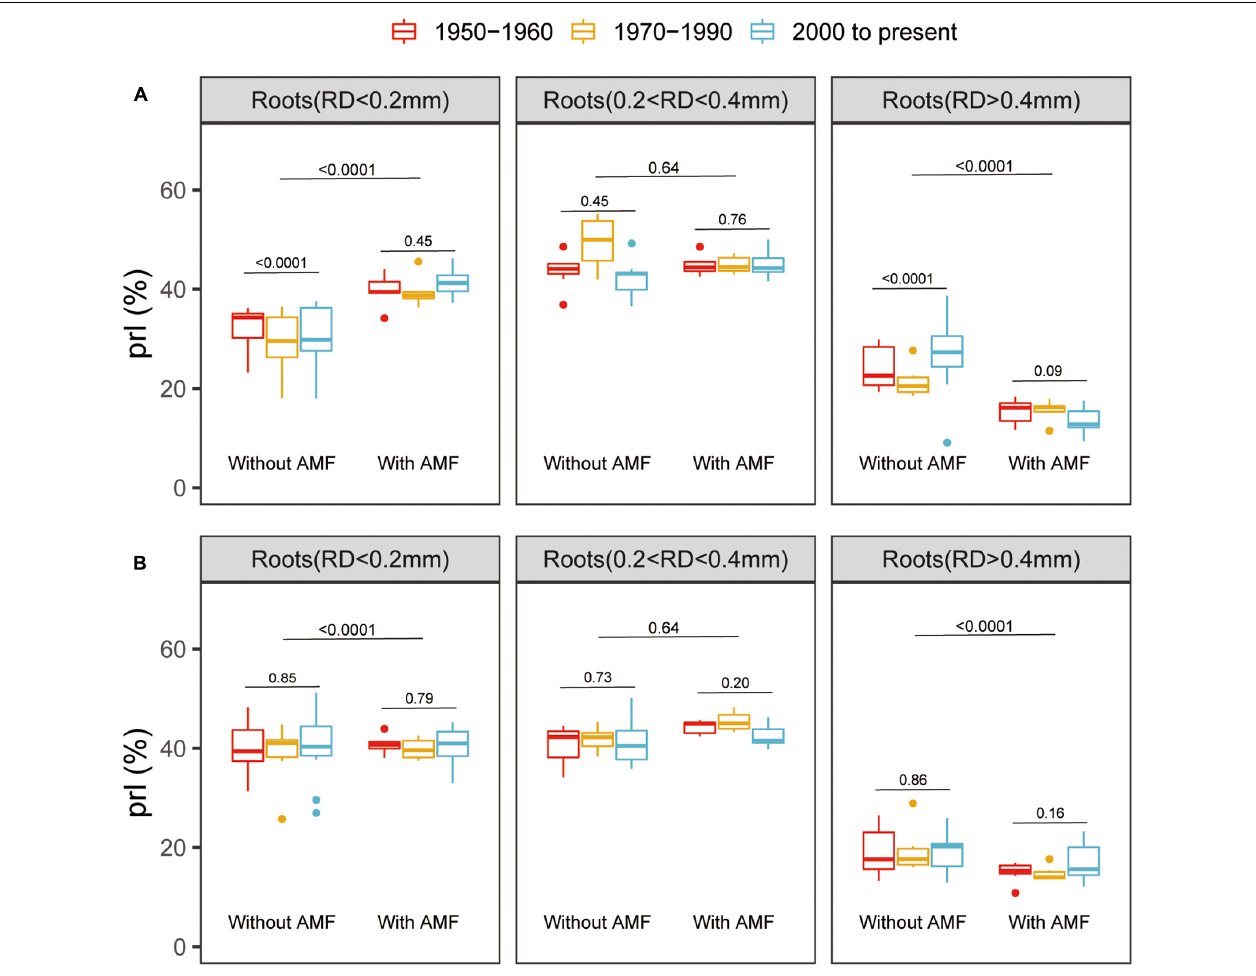
FIGURE 2 | Box plots showing the percentage root lengths (PRLs) with different root diameters (RD) for the total root length of cotton genotypes grown under low (A) or high (B) P supply and with or without inoculation with indigenous AM fungi. The groups (and bar patterns) are as follows: 1950–1960 (red), 1970–1990 (yellow), and 2000 to present (blue). We define those from “1950–1960” and “2000 to present” as the old and modern varieties, respectively. Boxes show first quartile, median, and third quartile. Whiskers extend to the most extreme points within 1.5 × box length. The Wilcoxon signed-rank test was carried out between the old and modern varieties or between with and without inoculation with indigenous AM fungi and the p -value is